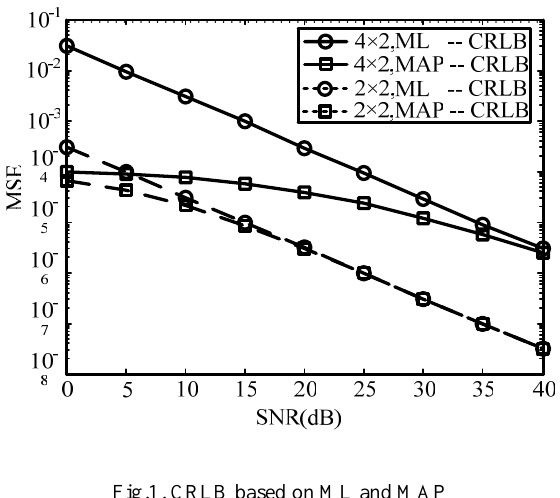
Fig.1. CRLB based on ML and MAP